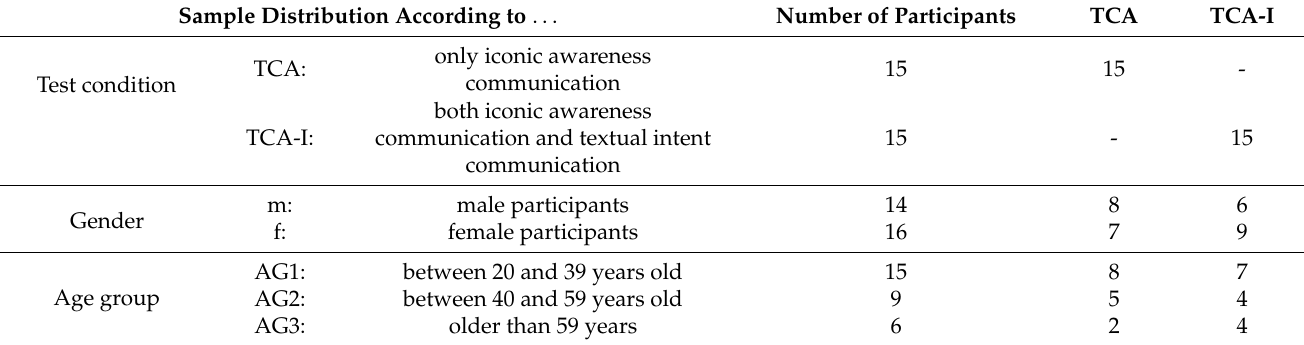
Table 3. Sample distribution with regard to experimental conditions, gender and age groups. Sample Distribution According to . . .